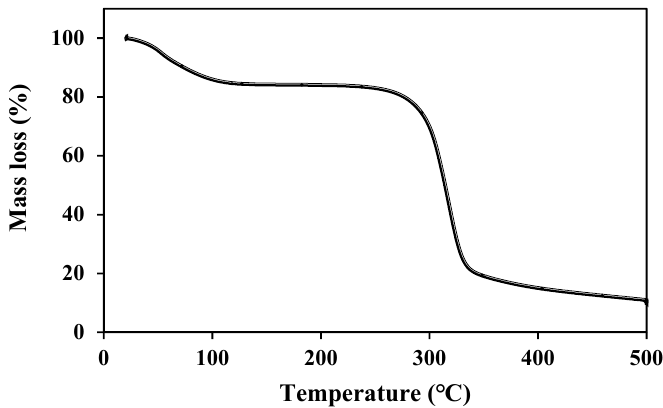
Figure 2. Thermal characterization of BSP (TGA).